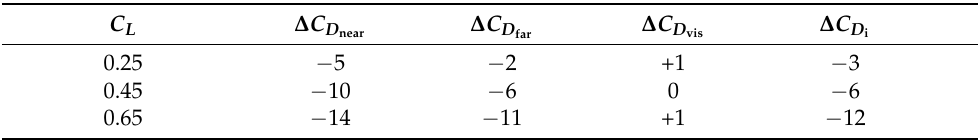
Figure 22. Comparison between IB-OB-1 (solid lines) and OFF (dashed lines) configurations at Re ∞ = 16.6 × 10 6 , M ∞ = 0.480. Drag polars with spurious drag detection on medium mesh levels; induced drag computed by Maskell’s formula. Table 11. Comparison between IB-OB-1 and OFF configurations at Re ∞ = 16.6 × 10 6 , M ∞ = 0.480 and same lift. Breakdown of the drag polars with spurious drag detection; induced drag computed by Maskell’s